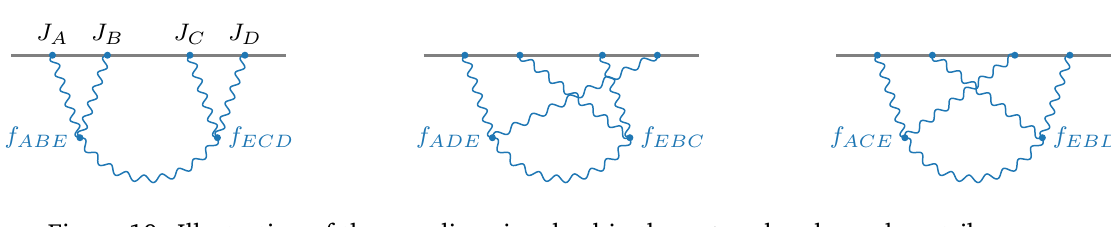
Figure 10: Illustration of the couplings involved in the s , t and u -channel contribu- tions to the four-point function of non-Abelian vector